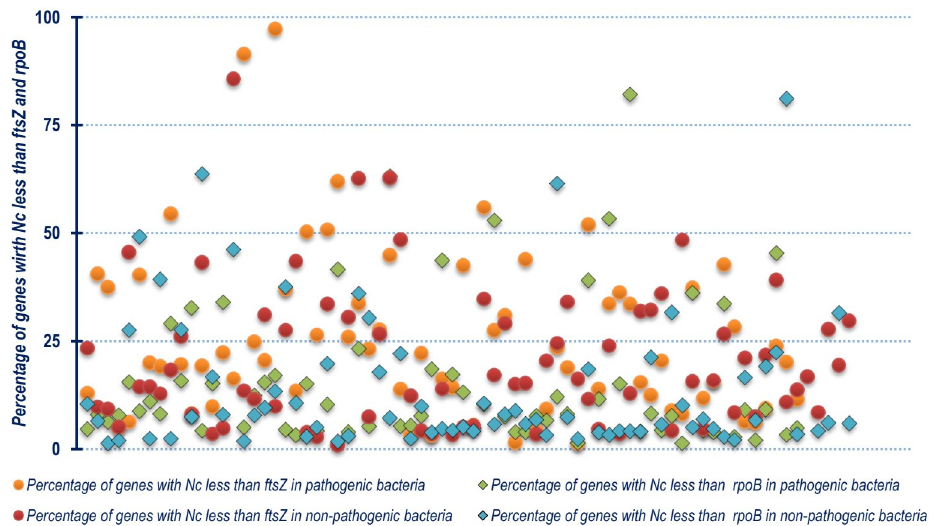
Fig 5. A scatter plot showing the distribution of the percentage of genes with Nc less than that of ftsZ and rpoB residing within the genome of each of the organism segregated on the basis of the non-pathogenic and pathogenic nature of the